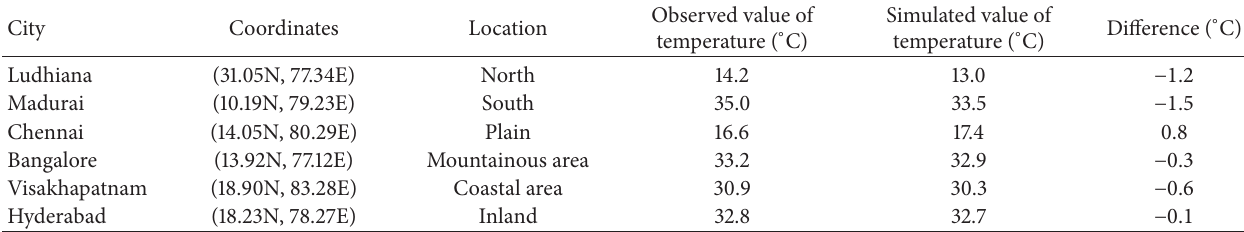
Table 2: Spatial pattern of the simulated and observed values of the annual average near-surface temperature in India for the year of 2010. City Coordinates Location